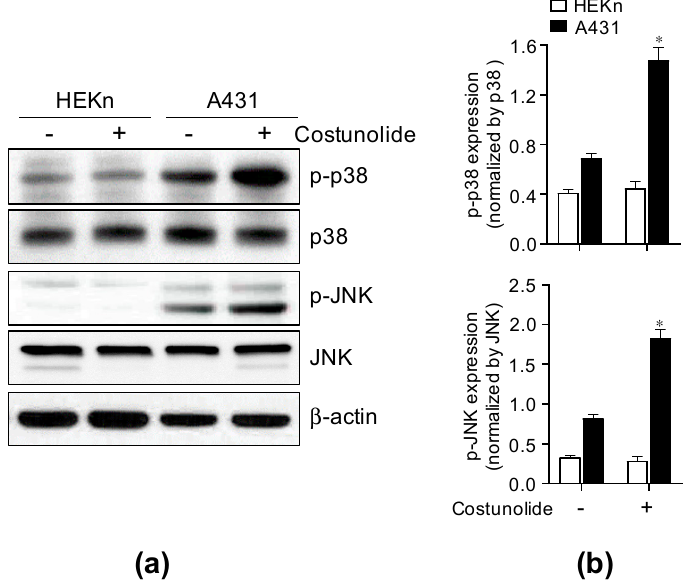
Figure 5. Effect of costunolide on JNK and p38 MAPK Pathway in HEKn cells and A431 cells. HEKn cells and A431 cells were treated with costunolide (0.8 µ M) for 4 h. Whole cell lysates were harvested. ( a ) Protein levels of p-p38, p38, p-JNK, and JNK were evaluated by western blotting. β -actin was used as the loading control. ( b ) Bar graphs display quantification of protein levels normalized by β -actin. * p < 0.05 as compared to vehicle-treated group.